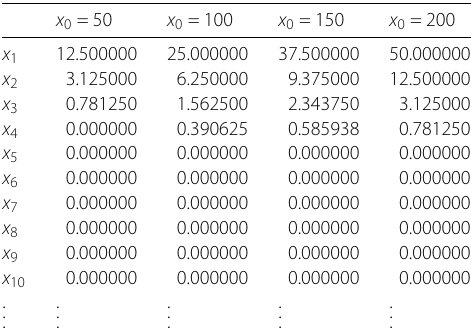
Table 1 The iterates of Picard iterations in Example 3.4